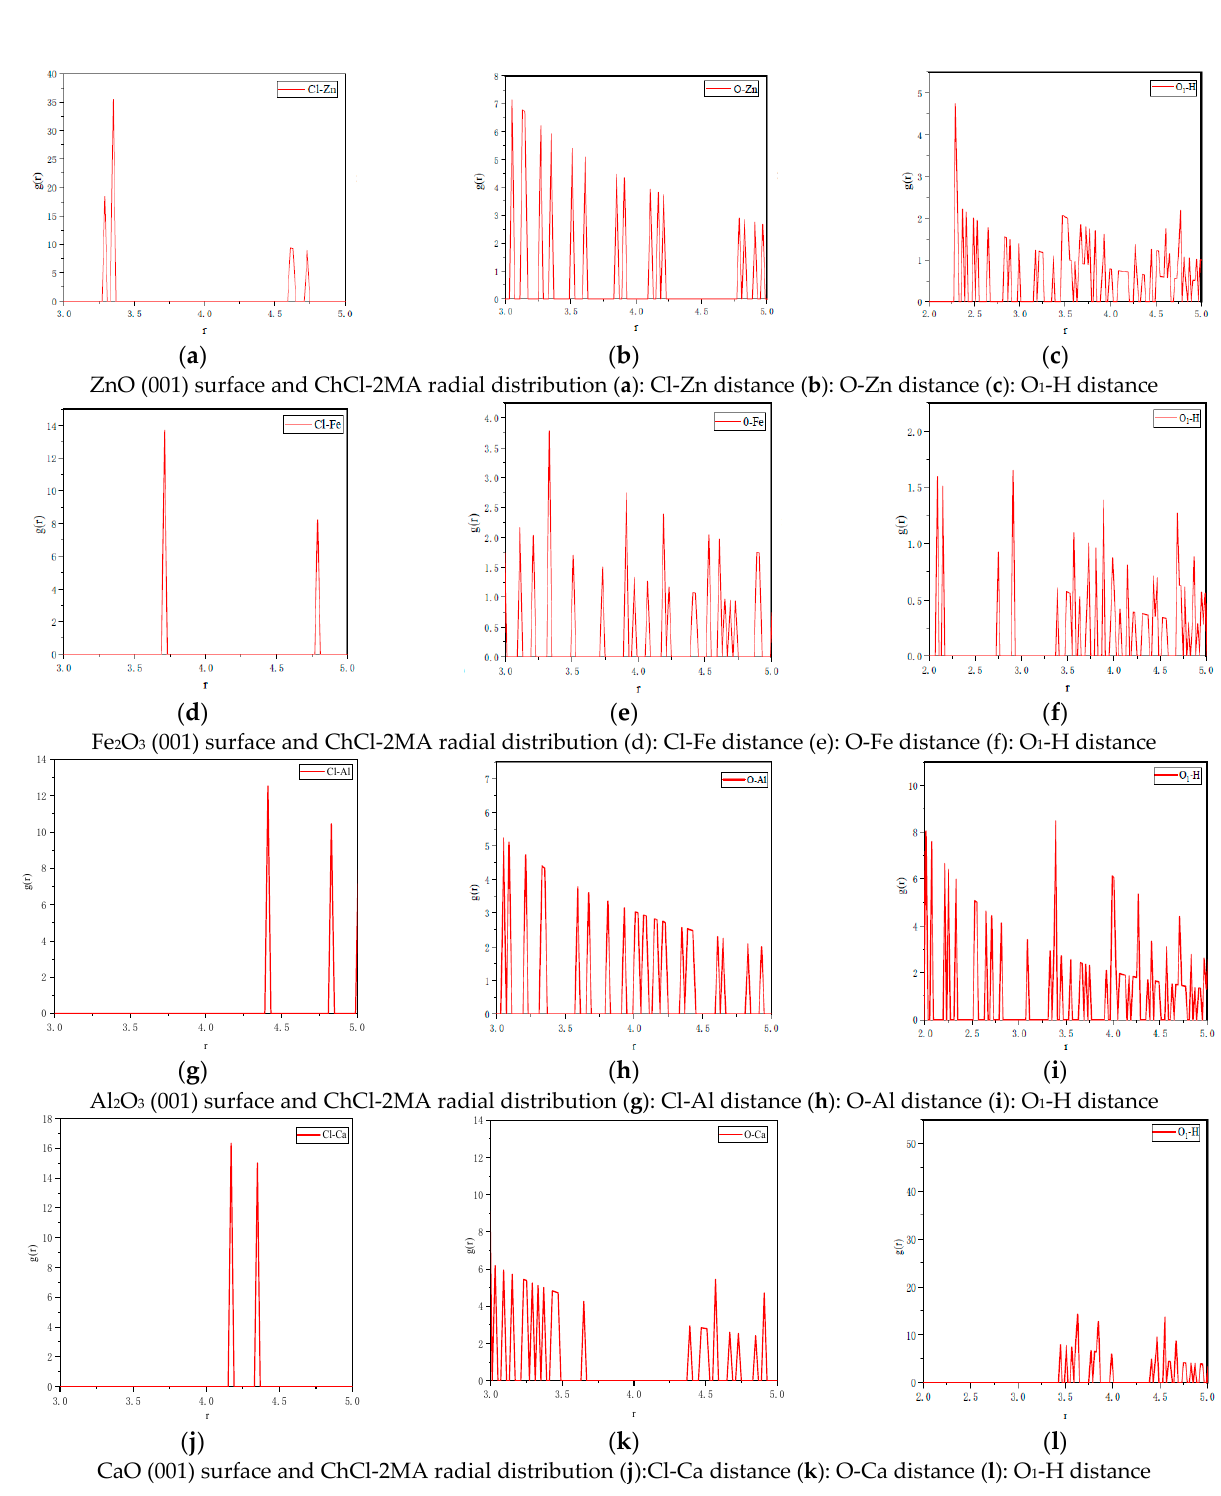
Figure 6. Radial distribution diagram of mineral adsorption model. ZnO (001) surface and ChCl-2MA radial distribution ( a ): Cl-Zn distance ( b ): O-Zn distance ( c ): O 1 -H distance. Fe 2 O 3 (001) surface and ChCl-2MA radial distribution ( d ): Cl-Fe distance ( e ): O-Fe distance ( f ): O 1 -H distance. Al 2 O 3 (001) surface and ChCl-2MA radial distribution ( g ): Cl-Al distance ( h ): O-Al distance ( i ): O 1 -H distance. CaO (001) surface and ChCl-2MA radial distribution ( j ): Cl-Ca distance ( k ): O-Ca distance ( l ): O 1 -H distance.